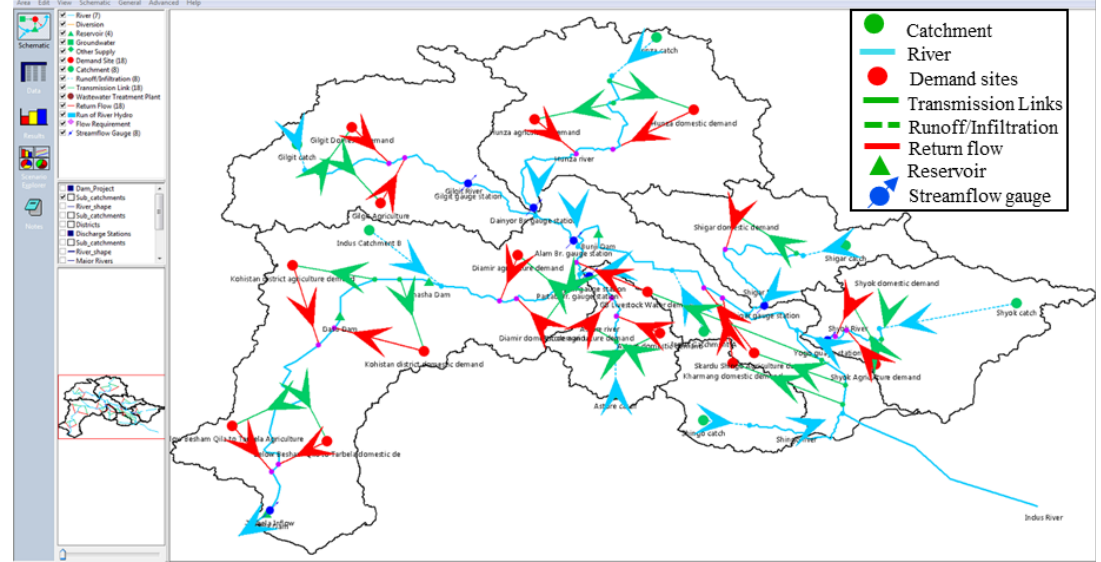
Figure 6. A schematic diagram showing the configuration of the WEAP model for the demand sites in the Upper Indus Basin (UIB).